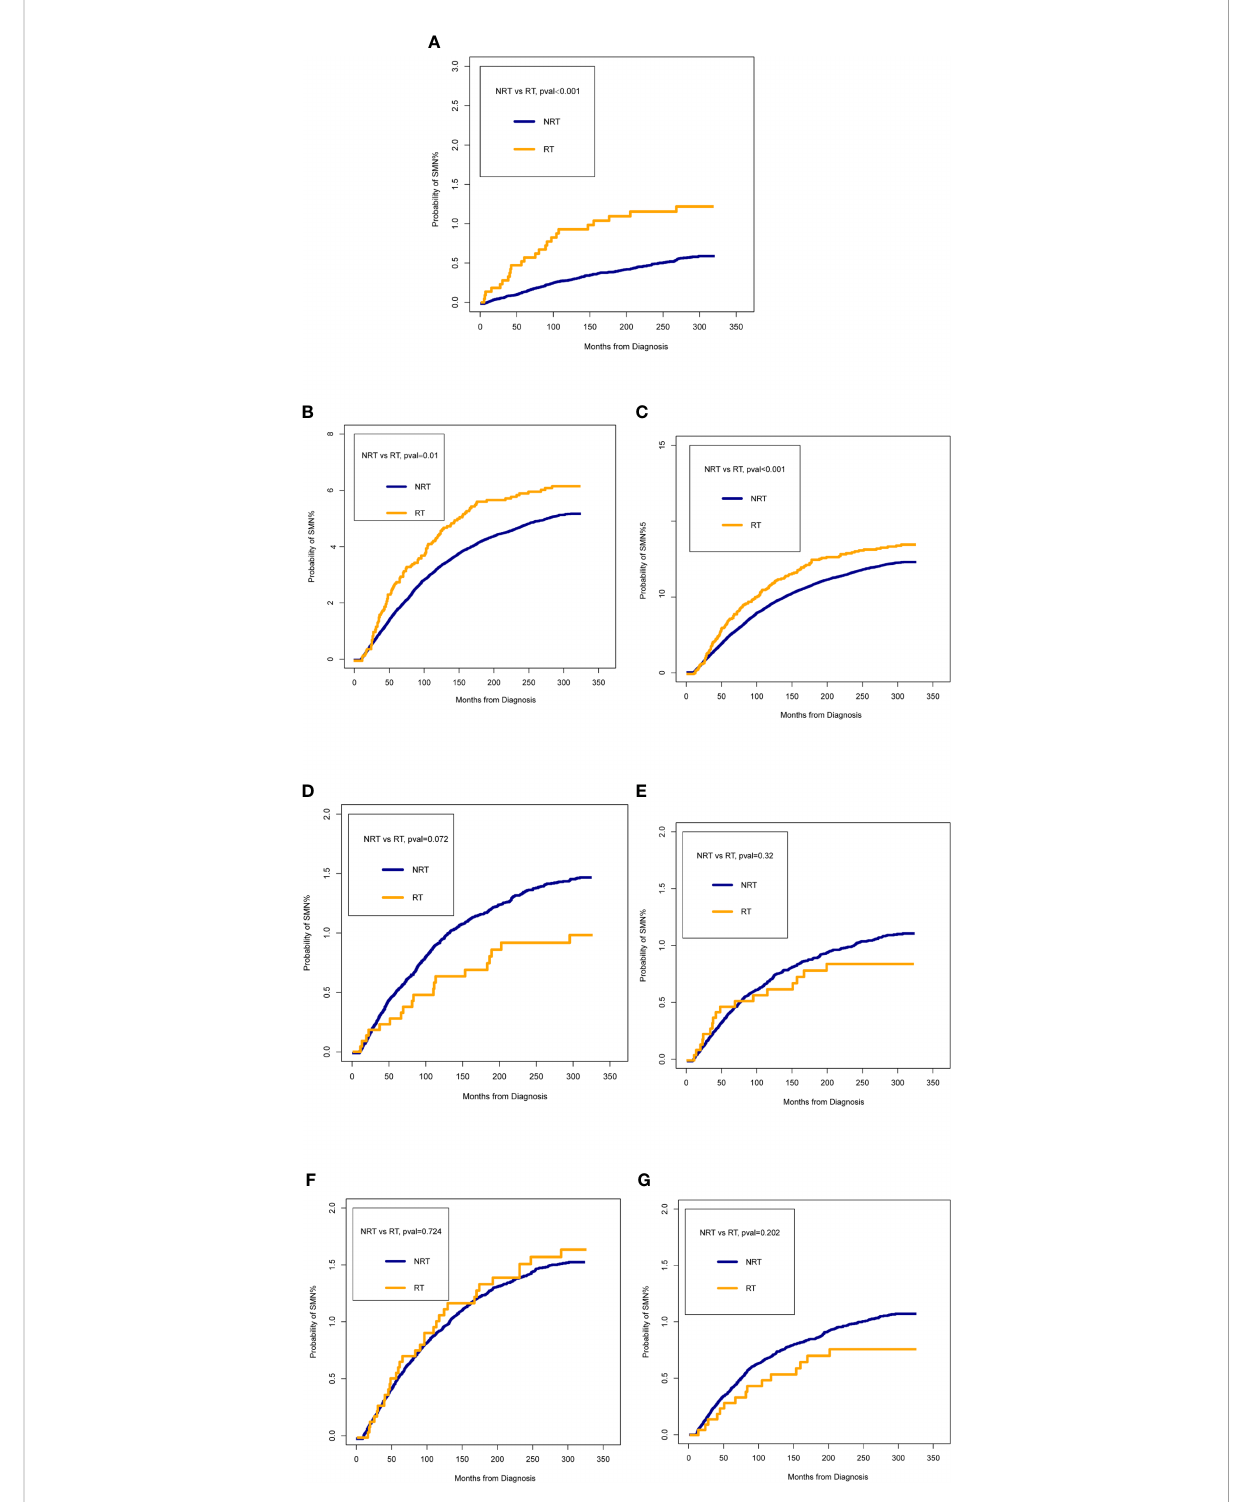
FIGURE 2 Comparisons of the probability of second malignant neoplasm (SMN) between patients who received radiotherapy (RT) and patients who did not receive RT. (A) all SMNs; (B) lung and bronchus cancer; (C) hematological malignancies; (D) other intrathoracic tumors; (E) abdominal tumors; (F) pelvic tumors; (G) other cancers. The time on the x-axis begins 60 months after bladder cancer